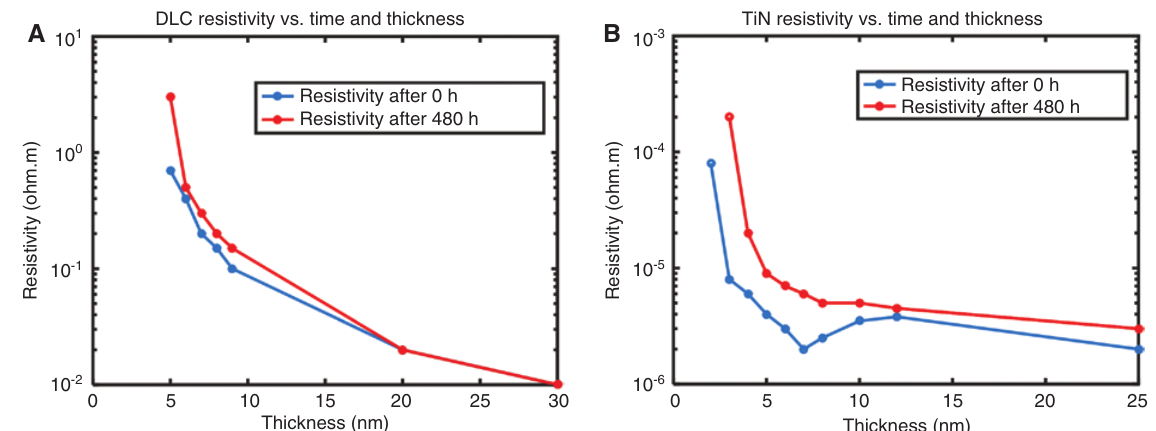
Figure 1: The thickness and exposure time dependent resistivity of (A) DLC film and (B) TiN film.